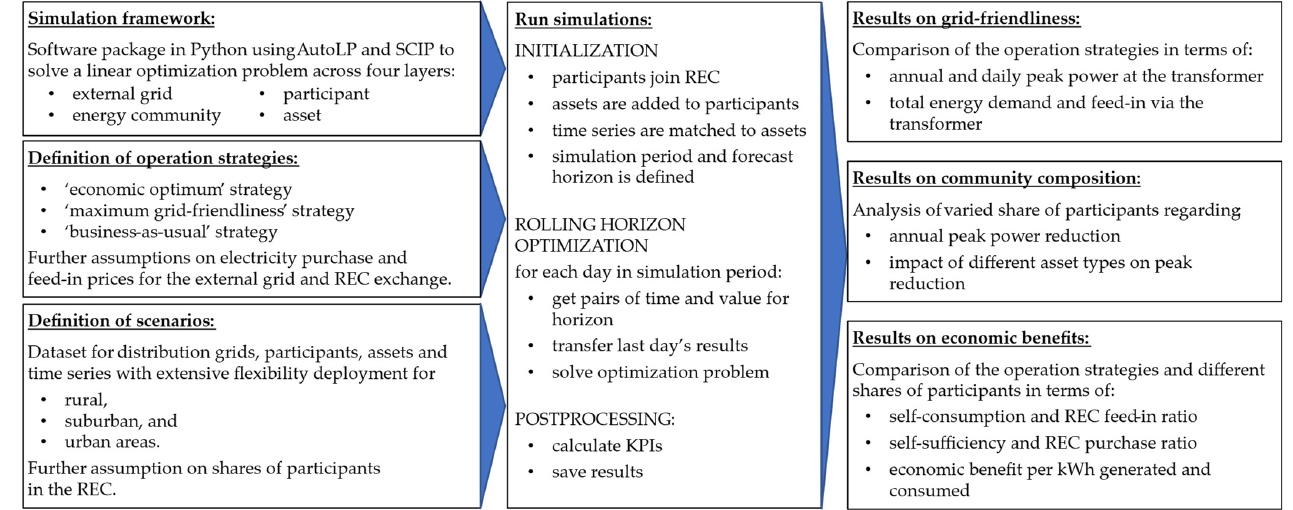
Figure 1. Graphical summary of the method.